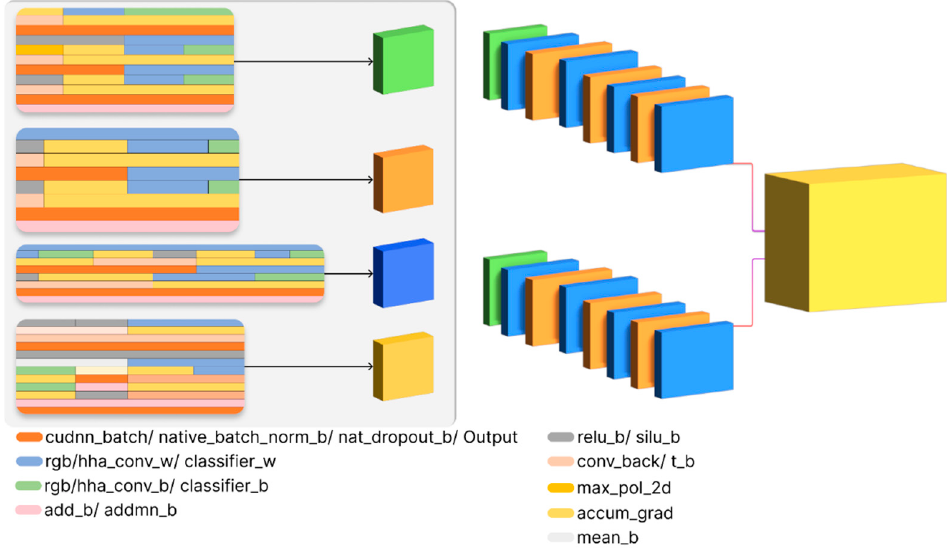
Figure 10. The core detail and layers of the DCNN for data fusion based on ResNet-18.